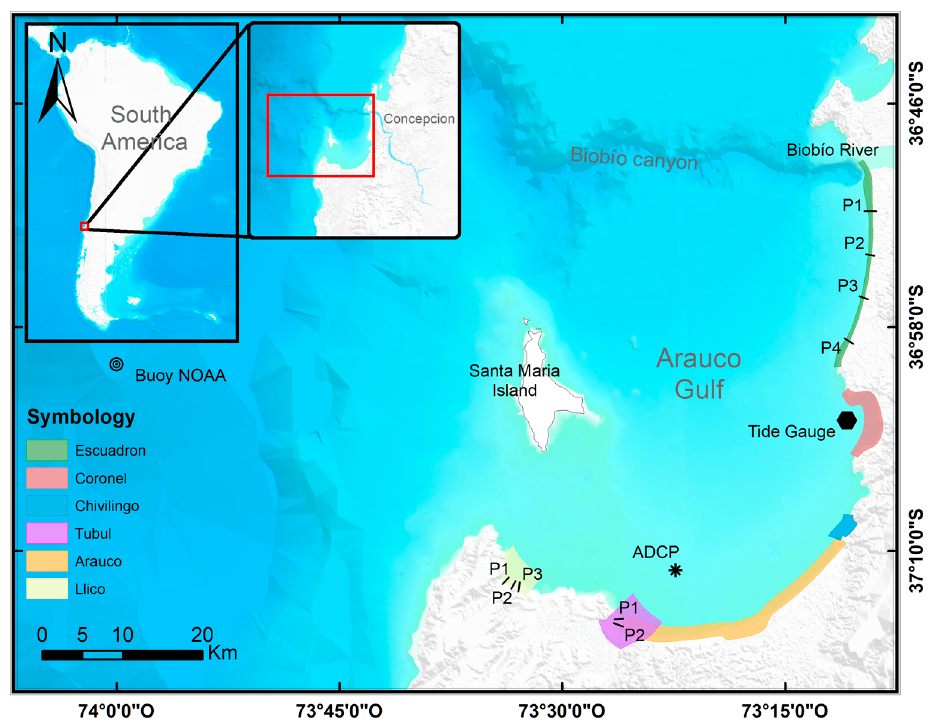
Figure 2. Location of the studied beaches along the Arauco Gulf. Cross-shore sections are illustrated in solid black line, NOAA virtual buoy with circles, colonel’s tide gauge with hexagon and ADCP with asterisk. P1–P4 are control transects at every beach.